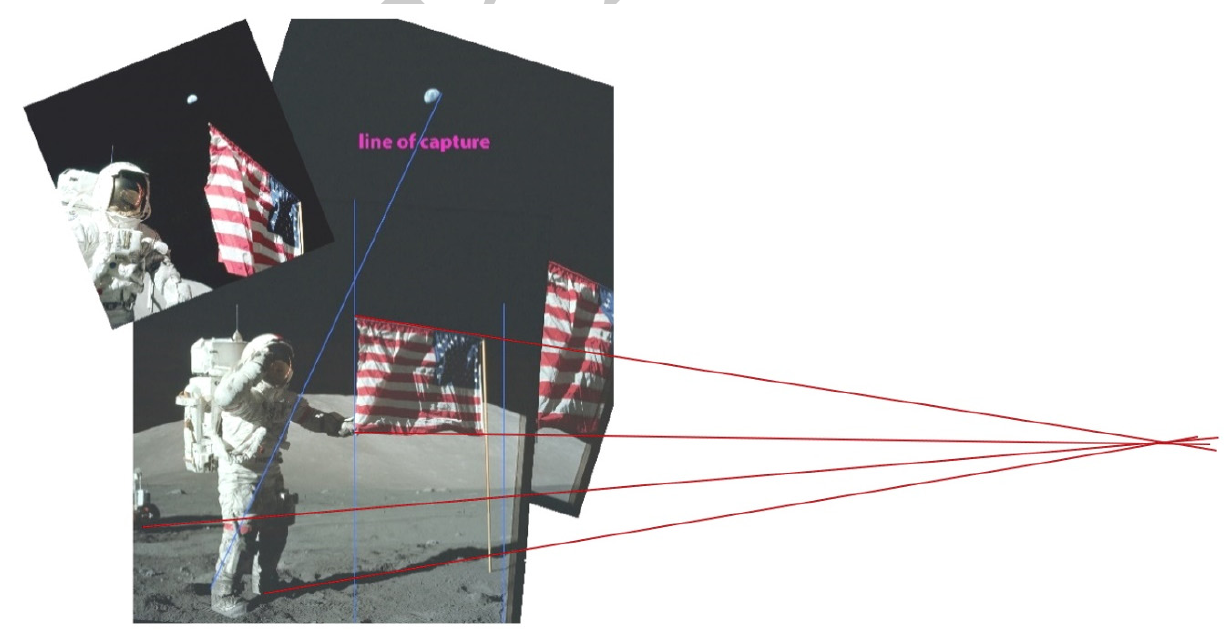
Figure 10. Composite of photos AS17-134-20386 and AS17-134-20387 showing the actual position of the Earth relative to the astronauts and the line at which the camera should be in order to capture the scene in photo AS17-134-20384 (top left). Notice that the shadows, with a few degrees of error, are running parallel to the flag’s horizontal length.